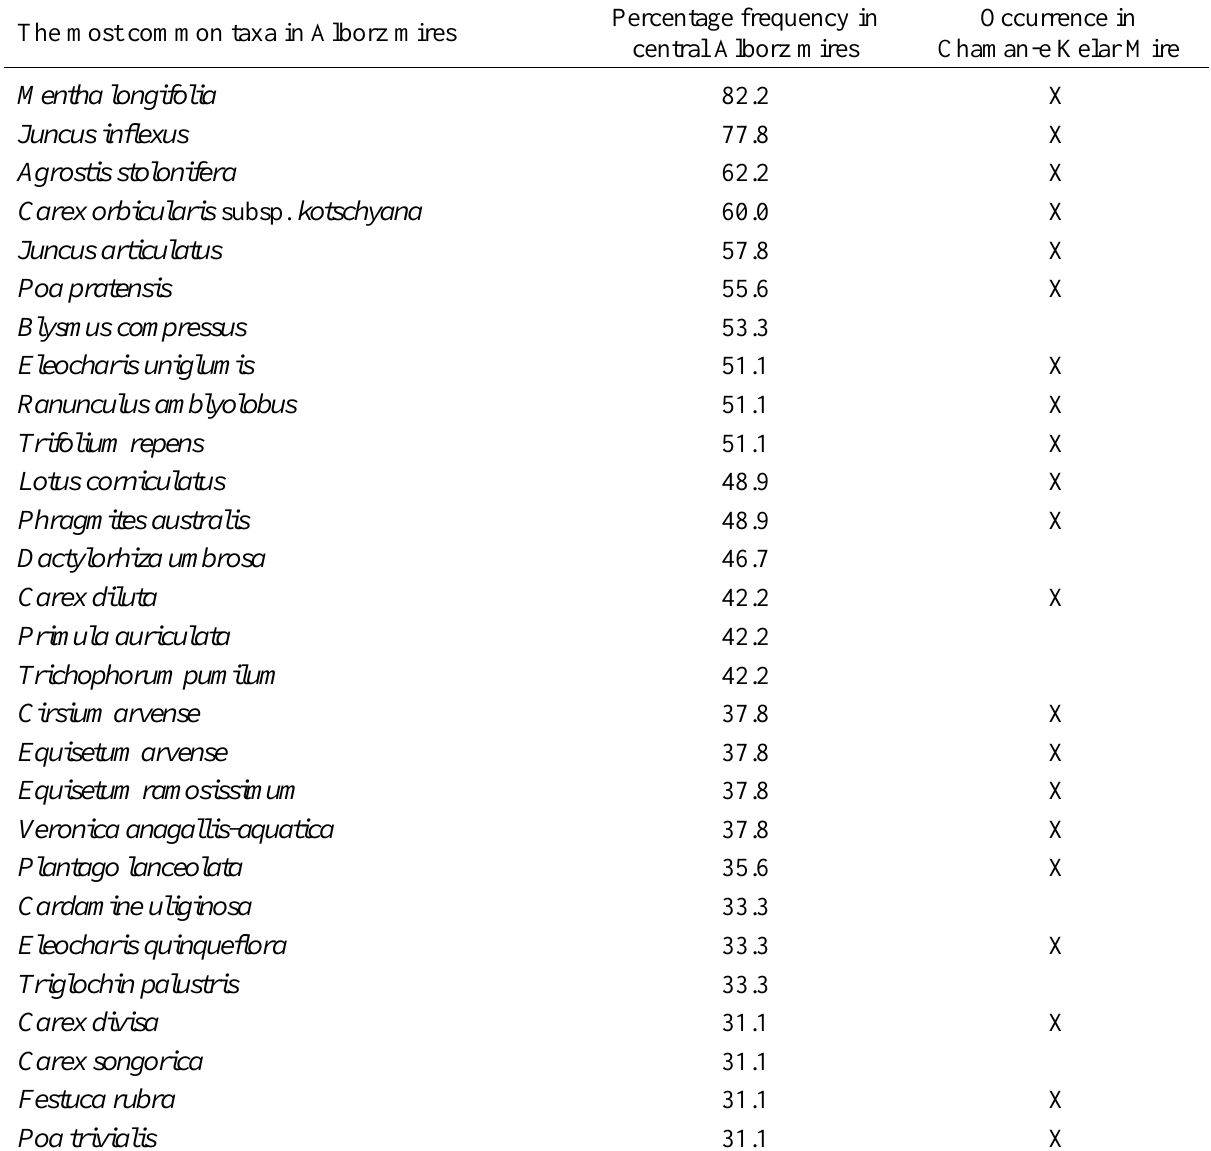
Table 2. Comparison of floristic elements occurring in ≥14 of 45 Central Alborz mires (Naqinezhad et al . 2010, Jalili et al . 2014) with the flora of Chaman-e Kelar Mire. The most common taxa in Alborz mires